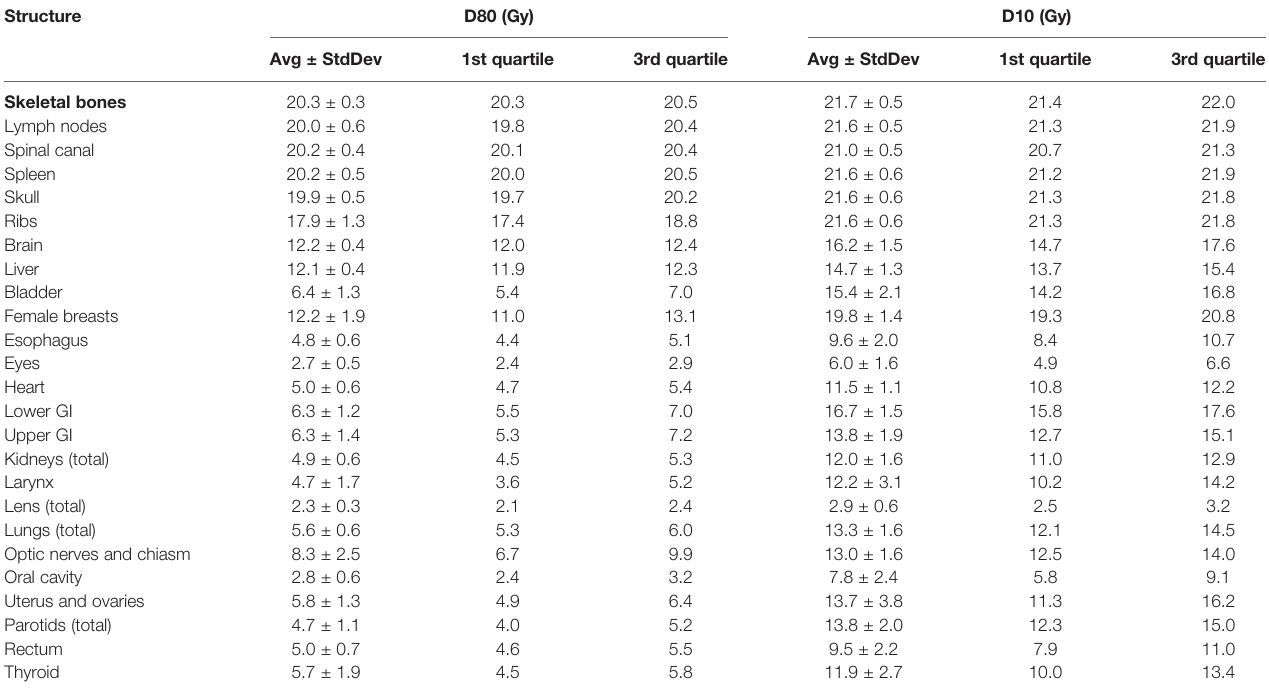
The target volumes are denoted with bold font. The structure of skeletal bones does not include the ribs or